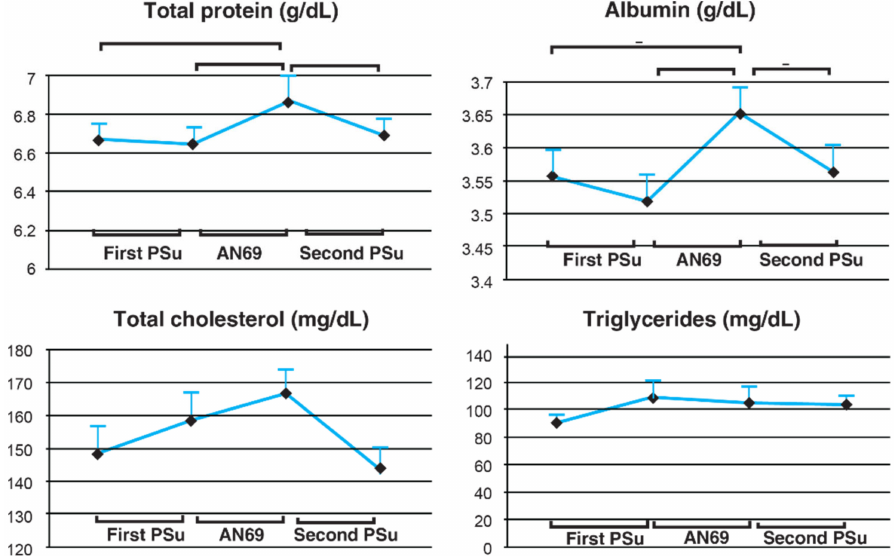
Figure 3. Changes in the nutritional indices during the PSu and AN69 periods [78]. PSu: polysulfone, AN69: acrylonitrile